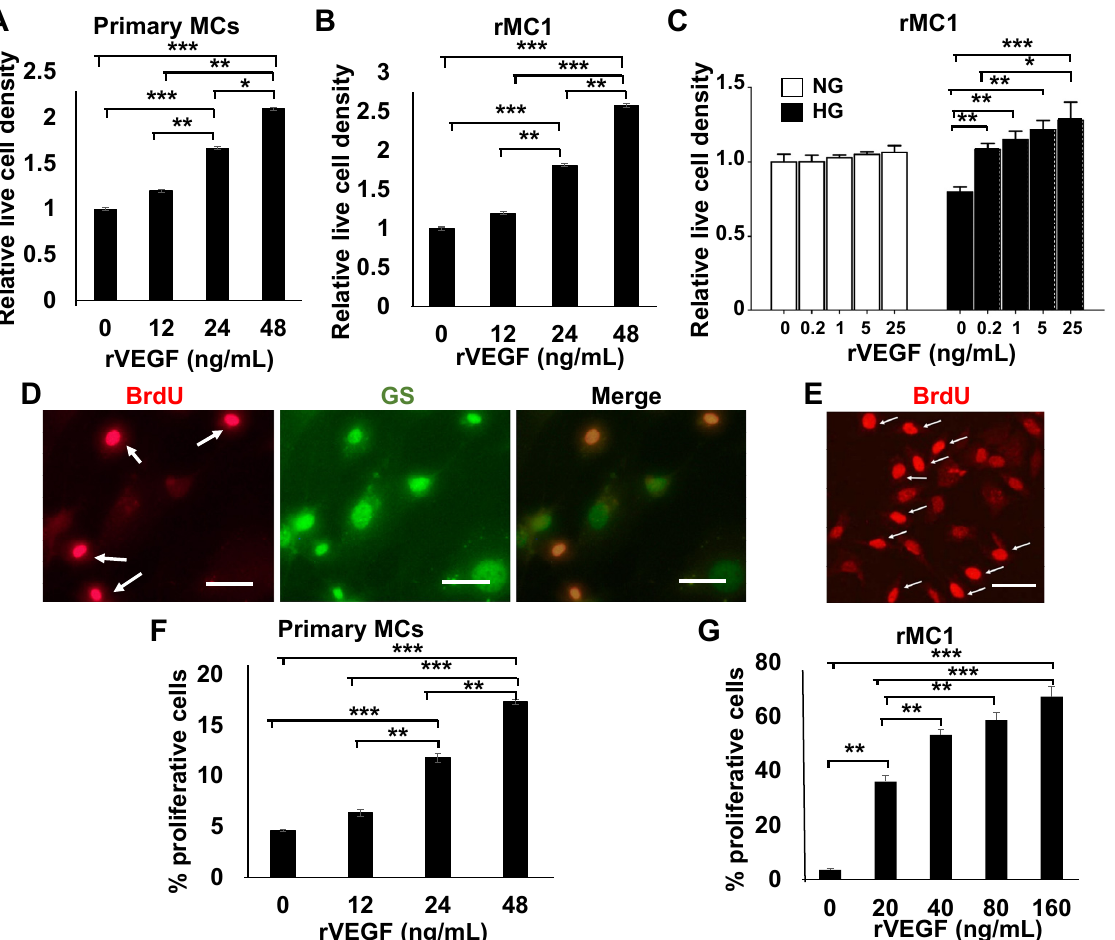
Figure 1. rVEGF-stimulated MC viability in mouse primary cells and rMC1 cells cultured in high HG media. ( A ) Relative live cell density of primary MCs cultured for 72 h on slides in HG media with and without rVEGF. ( B ) Relative live cell density of rMC1 cells cultured on slides for 36 in HG media with or without rVEGF. ( C ) Live cell analysis for rMC1 cells cultured for 36 h in NG or HG media with or without rVEGF supplement. ( D , F ) Images and quantifications of BrdU (red) stained (white arrows) primary MCs cultured for 24 h, in HG media with and without rVEGF supplement (24 ng/mL). ( E , G ) Images and quantifications of BrdU stained (white arrows) rMC1 cells cultured for 3 h, in HG media with and without rVEGF supplement (20 ng/mL). GS: Glutamine synthetase, Müller glial marker. Scale bars: 50 µ M. Graph bars represent mean ± SEM. *: p < 0.05; **: p < 0.01; ***: p < 0.001. rVEGF was capable of stimulating primary MC survival and proliferation in a dose-dependent manner under diabetes-like